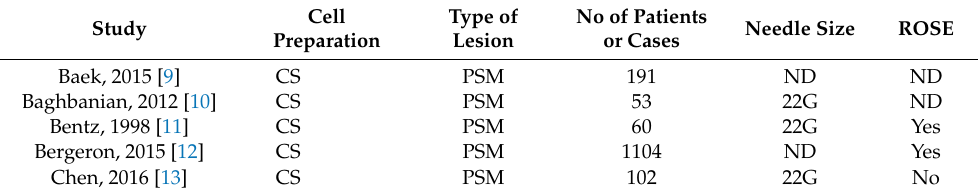
Figure 1. Flow chart for study search and selection methods. Table 1. Main characteristics of the eligible studies.